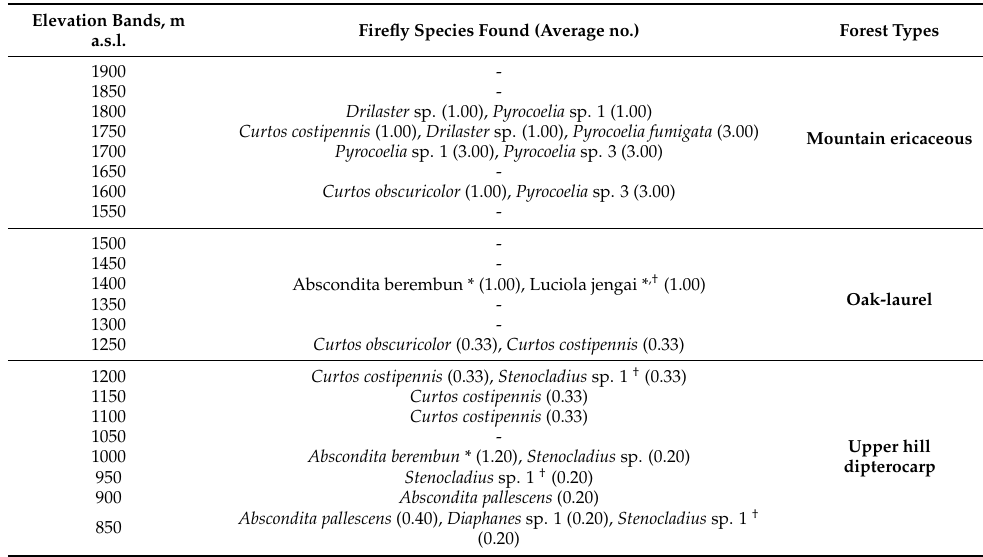
Table 1. Average individual numbers per firefly species according to elevation bands sampled. The average was calculated from data at each elevation among the five mountains. Elevation Bands, m a.s.l. Firefly Species Found (Average